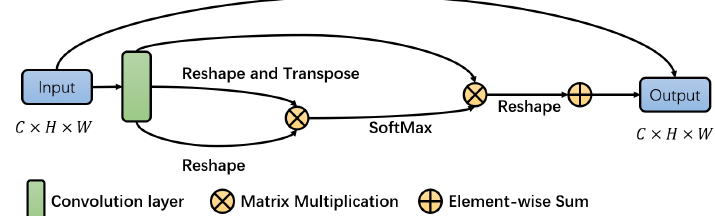
Figure 3. The detailed architectures of the channel attention block in